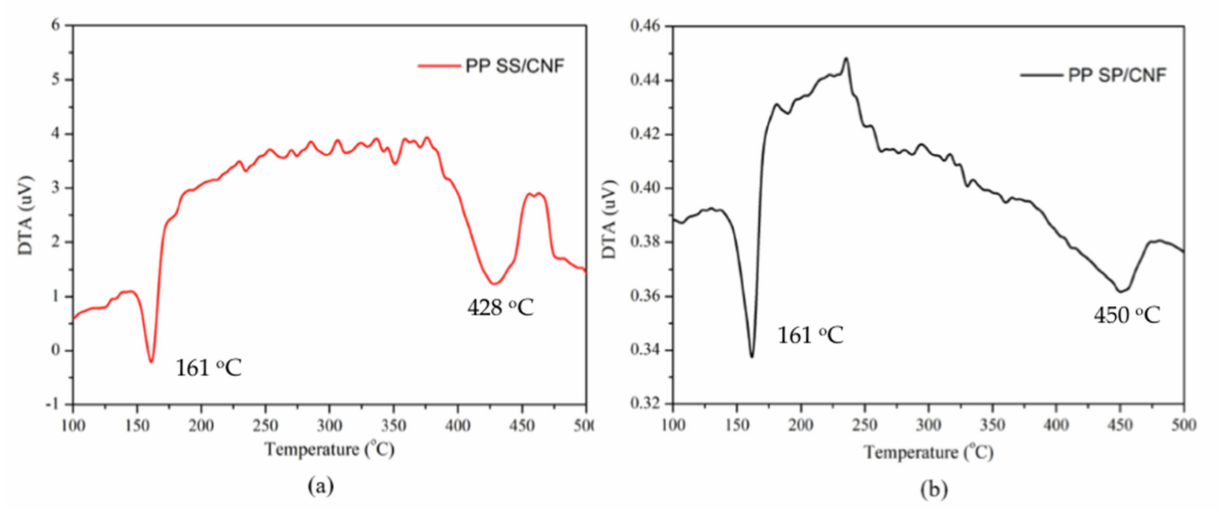
Figure 11. DTA curves of ( a ) PP SS/CNF, and ( b ) PP